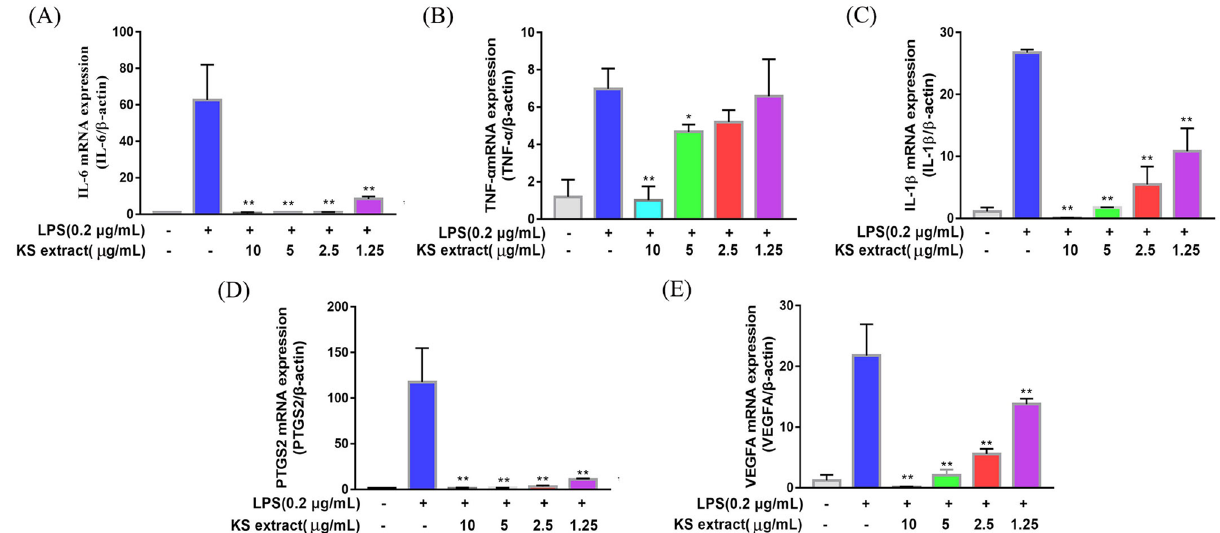
Figure 7. Effect of Kushen extract on key mRNA expression levels in RAW264.7 cells. The expression of ( A ) IL-6; ( B ) TNF-α; ( C ) IL-1β; ( D ) PTGS2 (COX-2); and ( E ) VEGFA mRNA levels were determined by RT-PCR. Data were presented as the mean ± SEM (n = 3), *p < 0.05 and **p < 0.01 versus LPS-treated group was considered statistically significant differences.